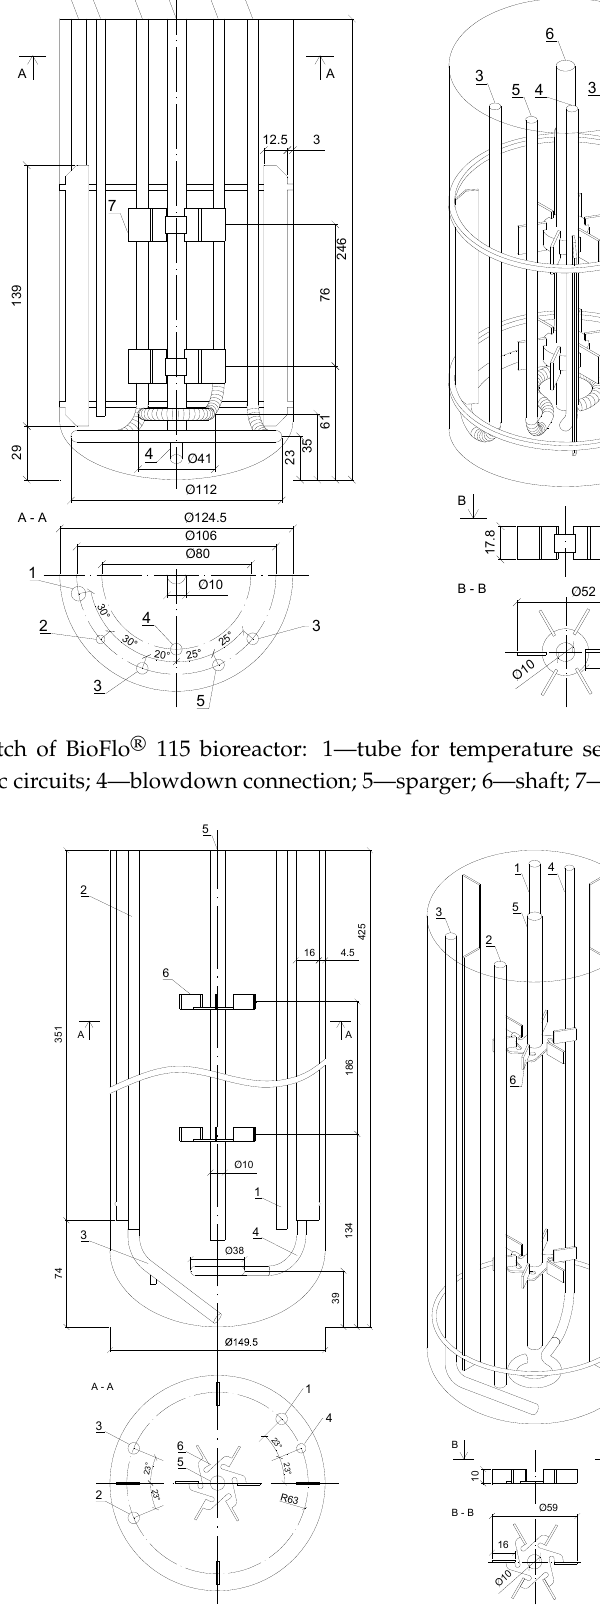
Figure 2. Sketch of BioFlo ® 415 bioreactor: 1—tube for temperature sensor; 2—sampling tube; 3—batching tube; 4—sparger; 5—shaft; 6—impeller.